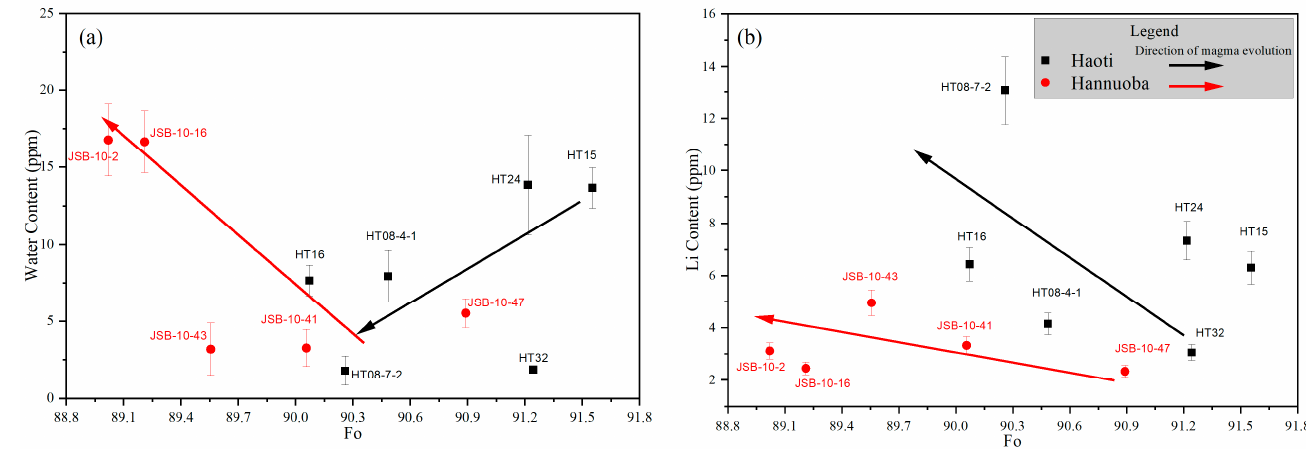
Figure 4. Olivine water content ( a ) and Li content ( b ) vs. Fo plot for the Hannuoba silicate-metasomatized and Haoti carbonatite-metasomatized peridotites.